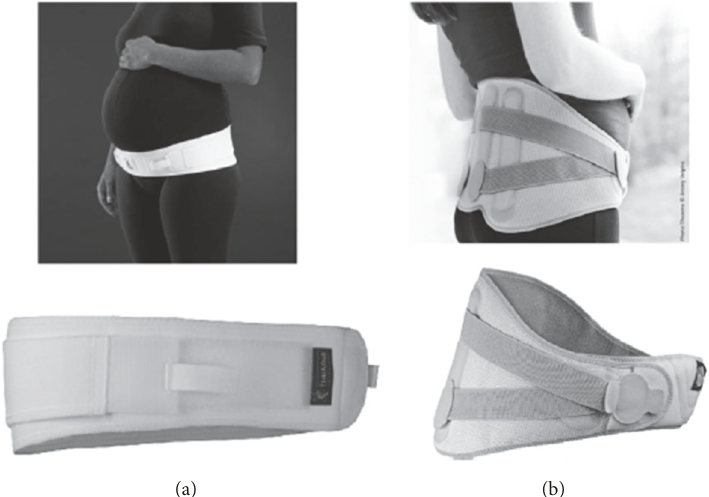
Figure 5: (a) Ortel-P (cid:2) pelvic maternity belt. (b) LombaMum Maternity Lumbar Brace. Source: Bertuit, Van Lint [25]. Image by: